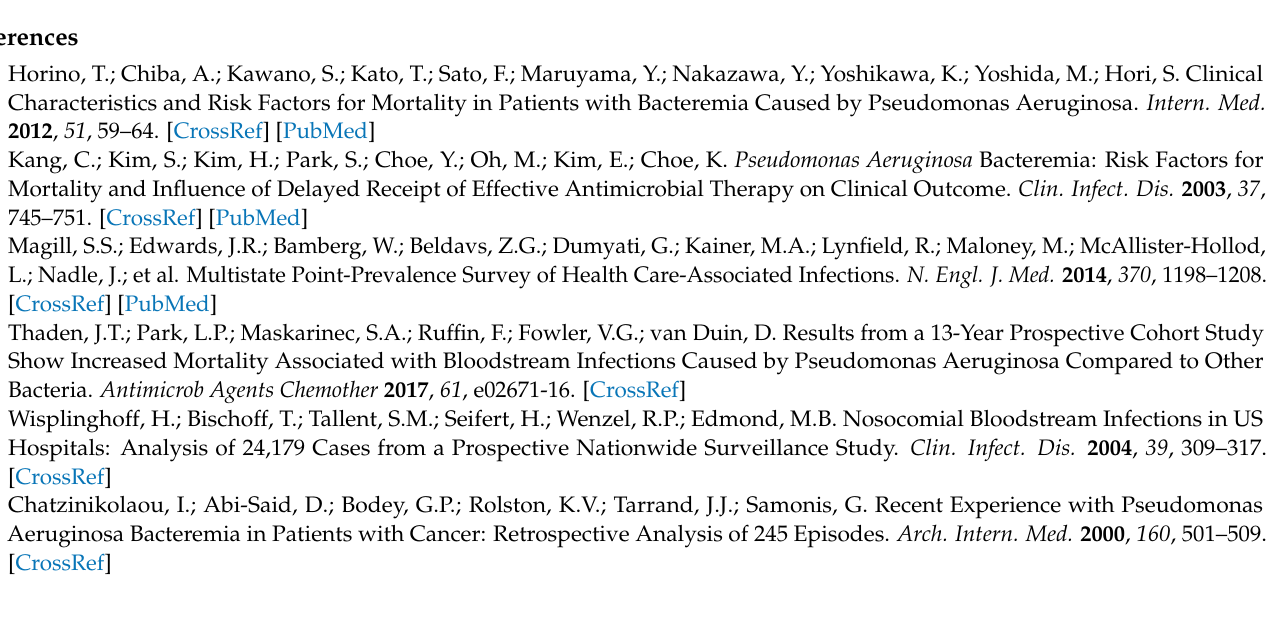
Table S5: Antimicrobial resistance of Pseudomonas aeruginosa strains isolated from patients’ blood cultures in regards to whether the patient was hospitalized in a ward or in the intensive care unit; Table S6: Antimicrobial resistance of the different Pseudomonas species isolated from patients’